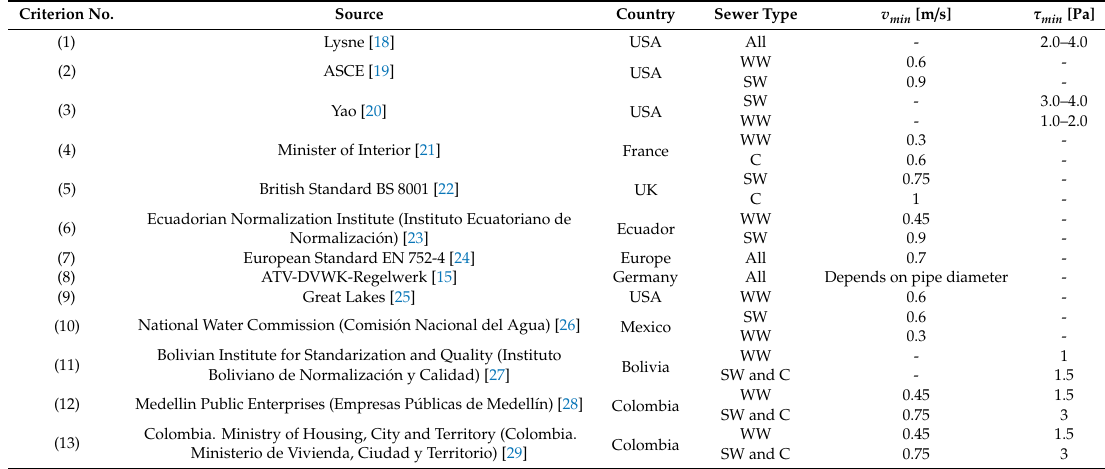
Table 1. Minimum velocity and shear stress